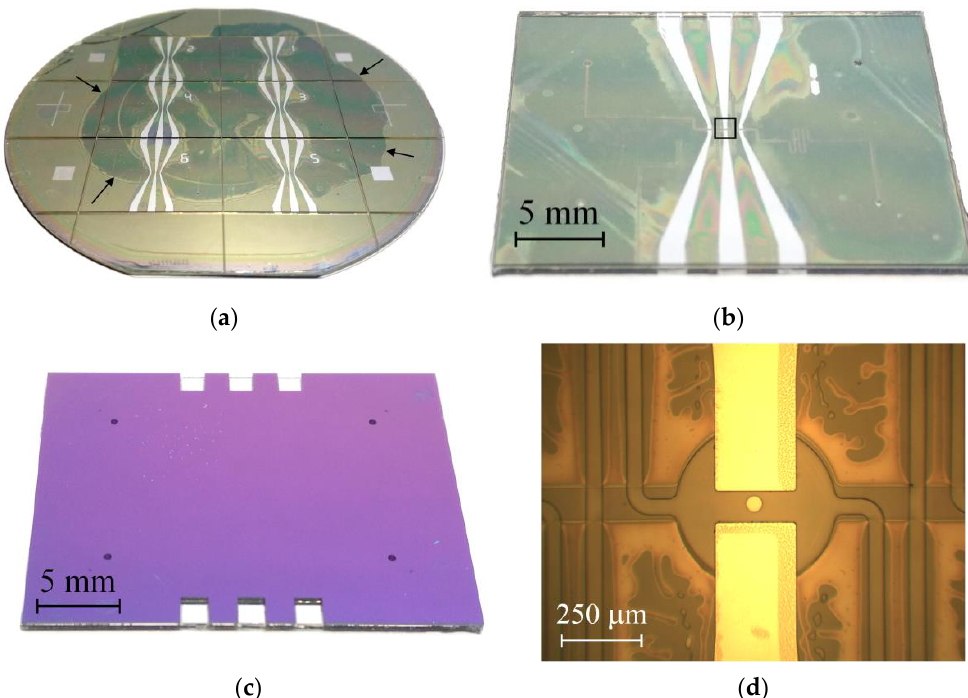
Figure 5. ( a ) A photo of the assembled wafers from the glass side. The arrows indicate the edge of the dark spot, where SU-8 is well bonded to SiN x . ( b , c ) A separate chip detached from the assem- bly. The photos are taken from the glass and silicon sides, respectively. The black rectangle in im- silicon sides, respectively. The black rectangle in image ( b ) indicates the actuator that is zoomed in panel ( d age ( b ) indicates the actuator that is zoomed in panel ( d ).